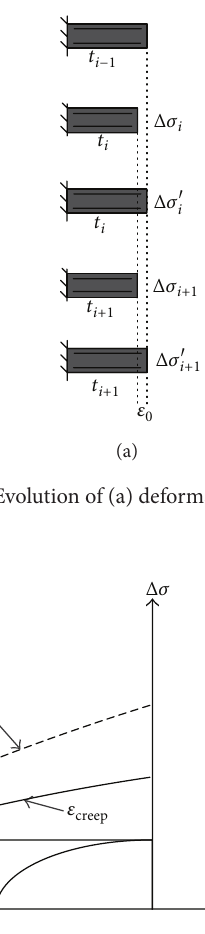
Figure 5: Evolution of creep strain and stress reduction of concrete. measured on specimens of 100 mm × 100 mm × 300 mm for elastic modulus test and 100 mm × 100 mm × 100 mm for splitting tensile test.